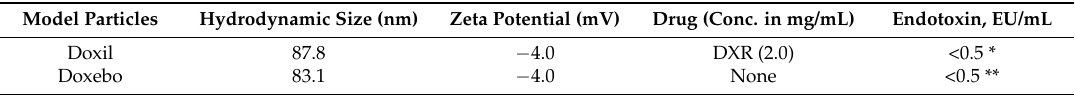
Table 1. Particle description and characterization summary. Each nanoparticle was tested at several dilutions. Endotoxin levels reported in this table are from the dilution 1:50. ** Doxebo interfered with Limulus Amoebocyte Lysate (LAL) at dilution 1:5, therefore no valid data can be obtained from that dilution; * Doxil did not interfere with the LAL at the dilution 1:5, and the result at that dilution was 0.08 EU/mL; DXR = doxorubicin.